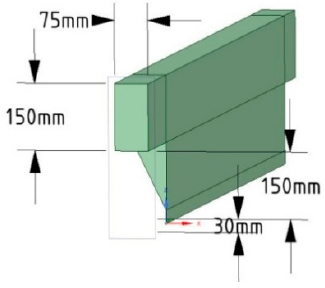
Figure 19. Plenum configuration upstream of each slot. The geometry is designed with a constant narrow channel to guarantee a fully de- veloped velocity profile, equal for each slot. Two different multi slot jet configurations (Table 8) have been simulated and compared to the existing configuration with round jets. Table 8. Main parameters of the two industrial configurations